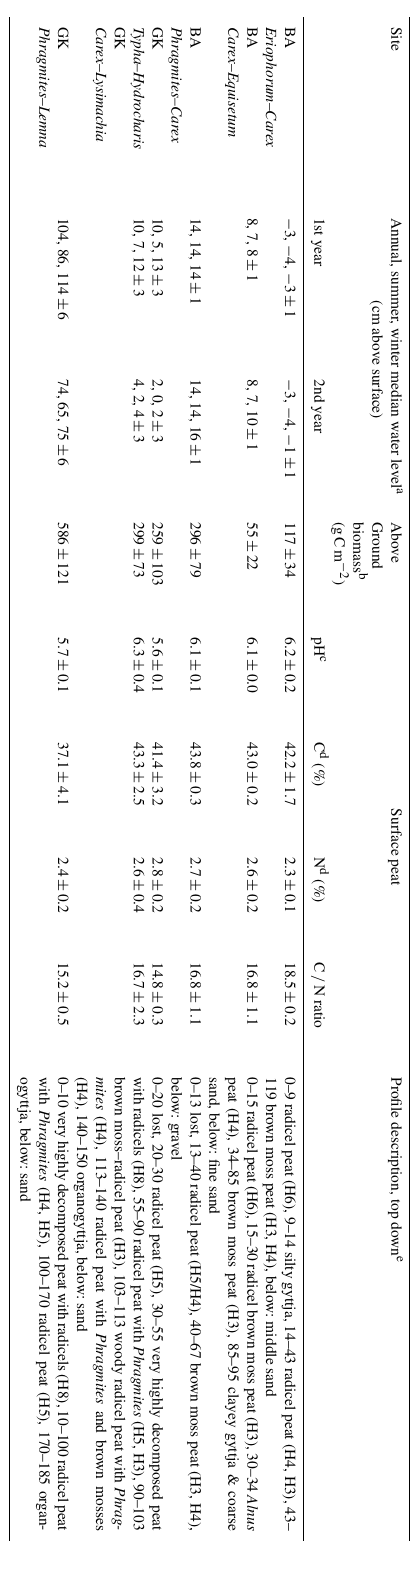
GPP largely balanced each other. GK Typha – Hydrocharis consequently varied between a source of 151 (41, 300) g CO 2 − C m − 2 yr − 1 in the first and a sink of − 113 ( − 418, 66) g CO 2 − C m − 2 yr − 1 in the second year. GK Carex – Lysimachia was a net CO 2 source in both years, releasing 166 (66, 252) g CO 2 − C m − 2 yr − 1 in the first and 216 (48, 470) g CO 2 − C m − 2 yr − 1 in the second year. On average the net CO 2 sink at Barcianicha decreased in the second year by 130 g CO 2 − C m − 2 yr − 1 or 56 % but in- creased at Giel’cyka˘u Kašyl’ by 259 g CO 2 − C m − 2 yr − 1 or 263 % compared to the first